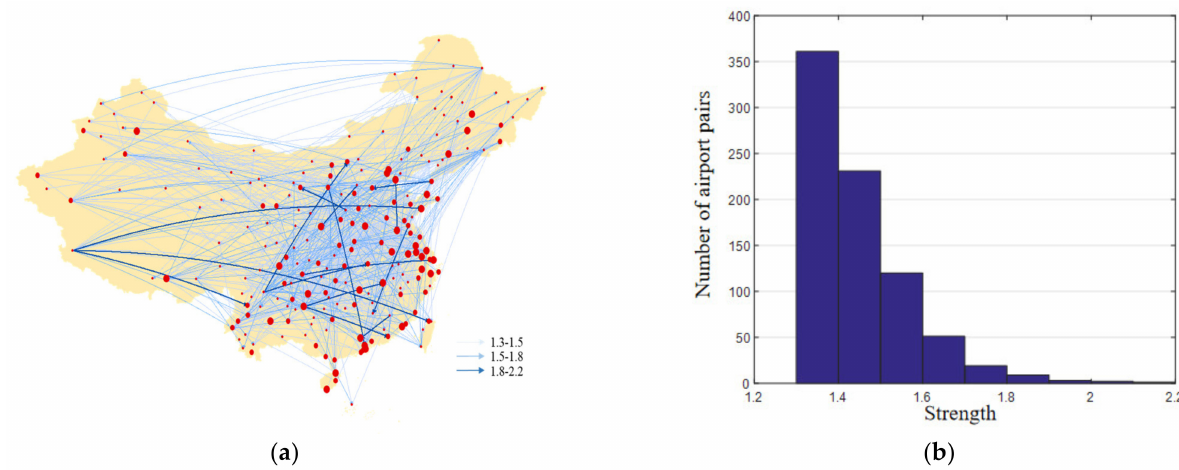
Figure 15. Delayed propagation causality network with an out-degree greater than 10. ( a ) Causality network ( b ) Number of airport pairs with different